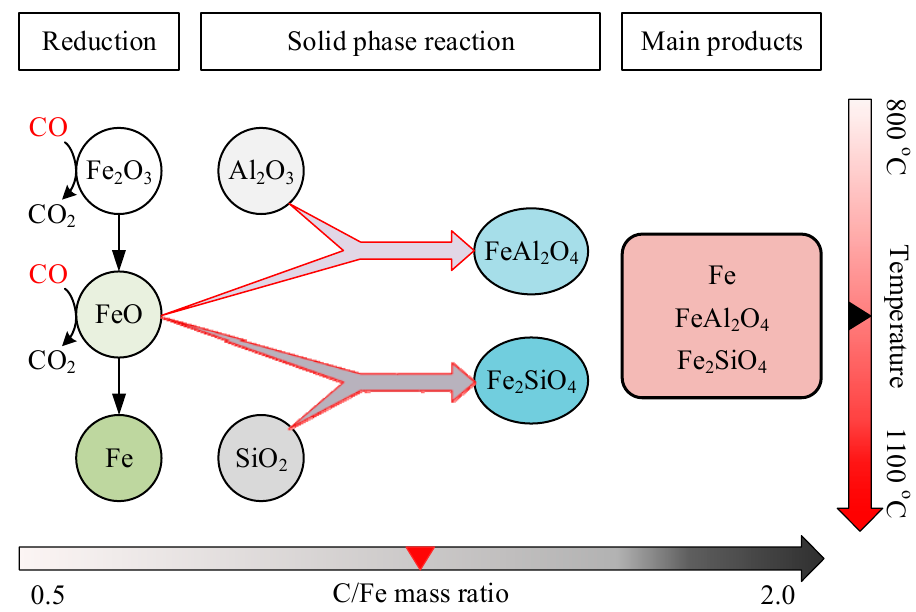
Figure 11. The mechanism of reducing high-aluminum iron ore (HA ore) by CO. Metals 2018 , 12 , x FOR PEER REVIEW